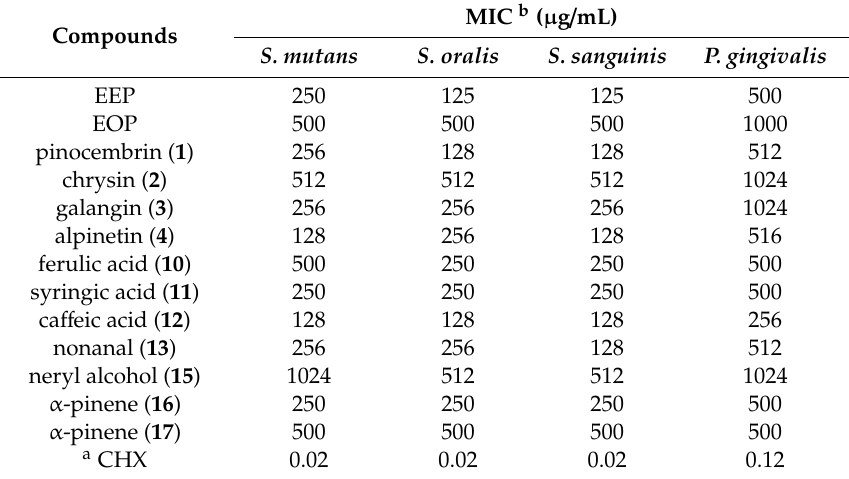
Table 4. Antimicrobial activity of ethanolic extract and compounds 1 – 4 , 10 – 13 , 15 – 17 , and chlorhexidine digluconate (CHX) a